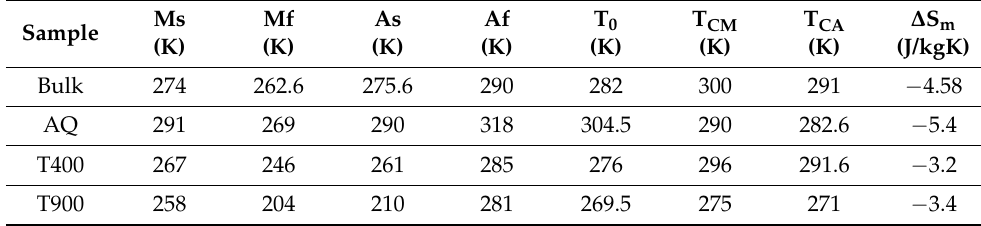
Table 1. DSC transformation temperatures (Ms, Mf, As, Af), thermodynamic equilibrium temperature T 0 , the Curie temperatures (T CM , T CA ) and magnetic entropy change ∆ S m (at 5 T) for studied samples. T CA is determined on cooling and T CM is determined on